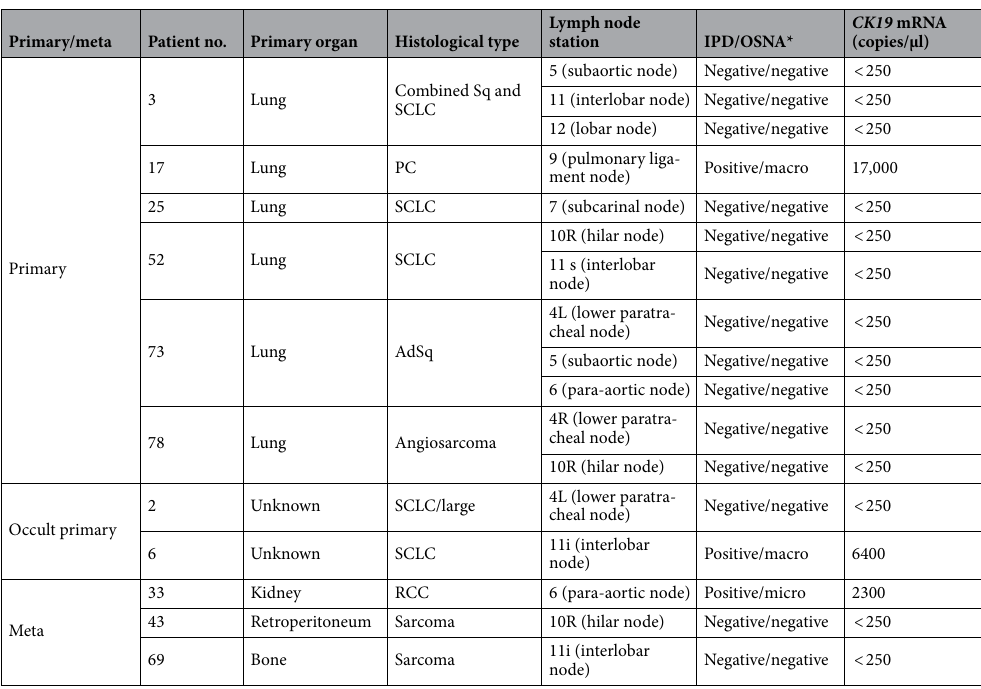
Table 4. Primary cases with minor histological subtype and metastasis cases. IPD, interoperative pathological diagnosis; Meta, metastasis; Sq, squamous cell carcinoma; SCLC, small cell lung cancer; PC, pleomorphic